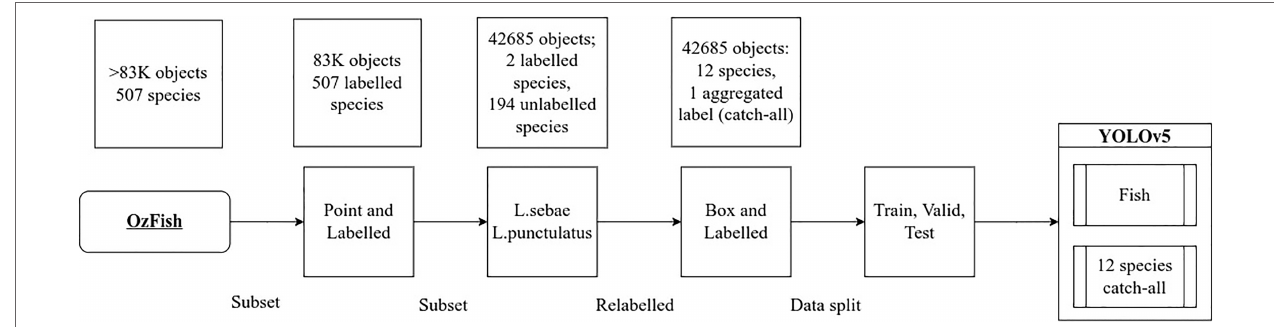
FIGURE 2 | Data preparation steps and subsetting, identifying all images that included species labels followed by filtering two primary key species then manually relabelling all fish with bounding boxes and species generated the data used to train